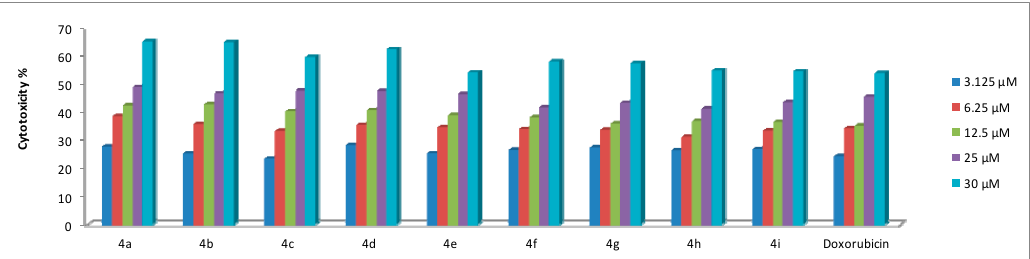
Figure 6. Dependent cytotoxic activities of new compounds on A549 cancer cells according to the MTT assay.